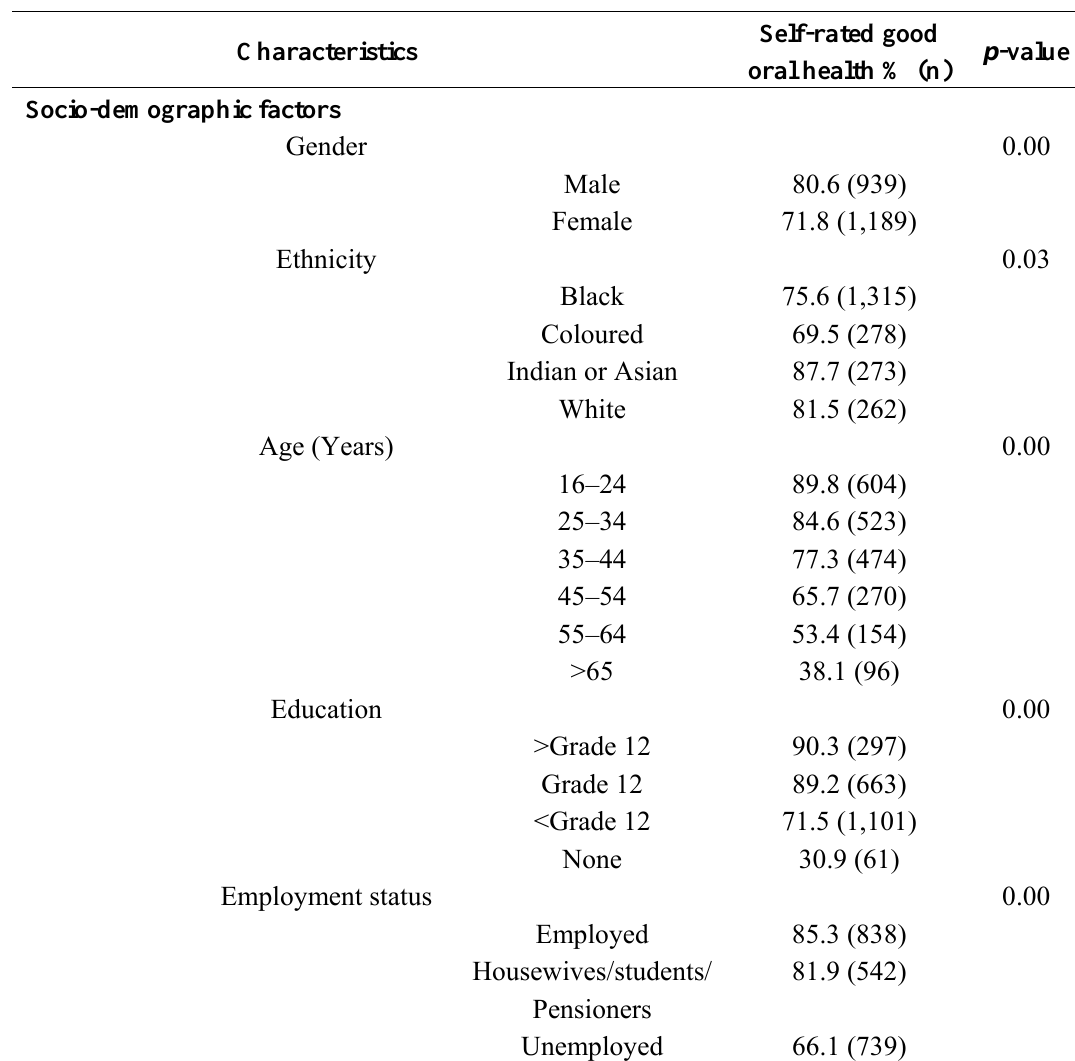
Table 1. Bivariate relationship between self-rated good oral health status and individual- level risk